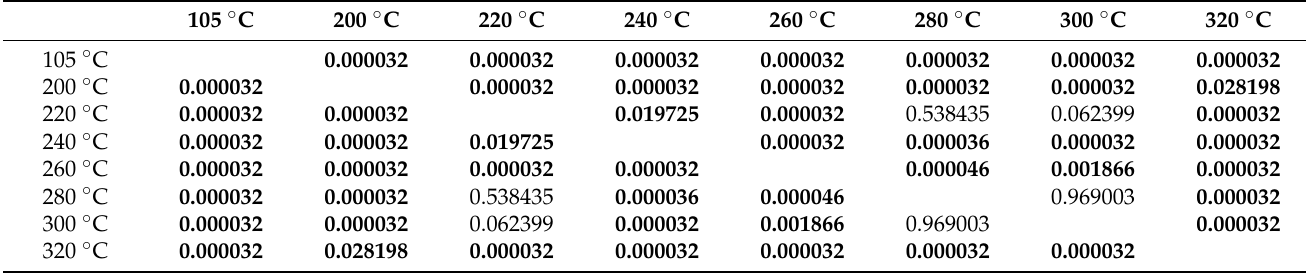
Table A2. Significant differences for the EMC variable for the effect of torrefaction temperature (TT) according to Tukey’s test (HSD) for grapefruit peels.